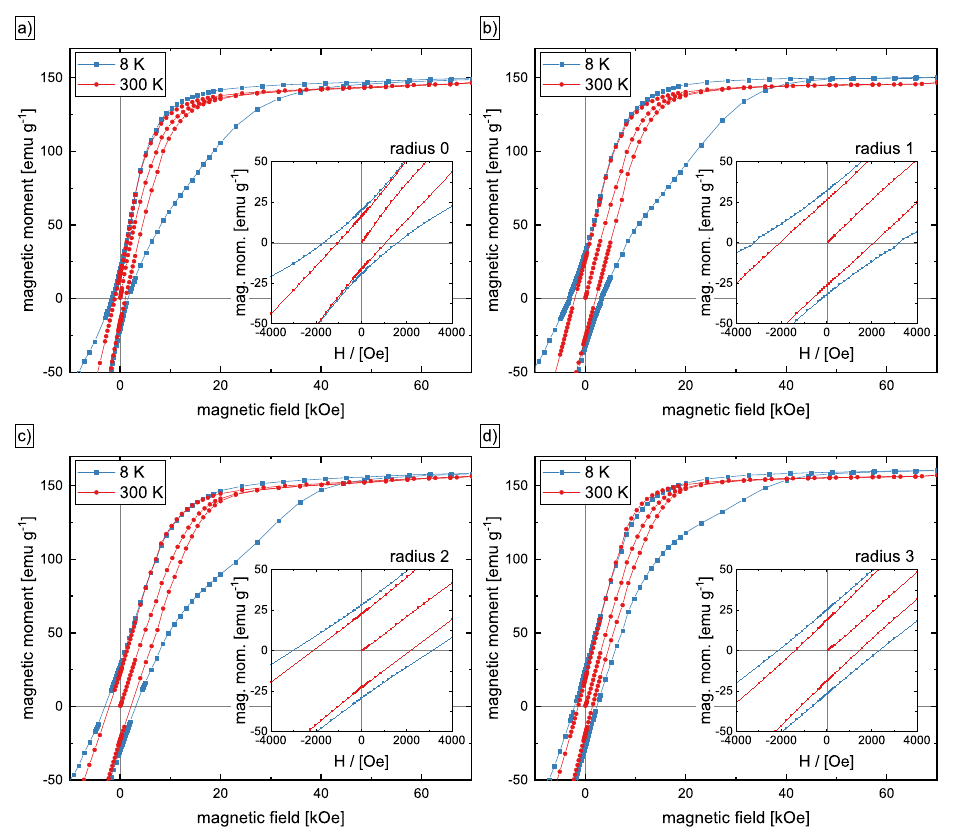
Figure 8. Hysteresis loops of HPT processed Fe-SmCo samples measured at 300 K (red, dots) and 8 K (blue, cubes) of a 47 wt.% Fe–53 wt.% SmCo 5 sample at ( a ) r0, ( b ) r1, ( c ) r2 and ( d )